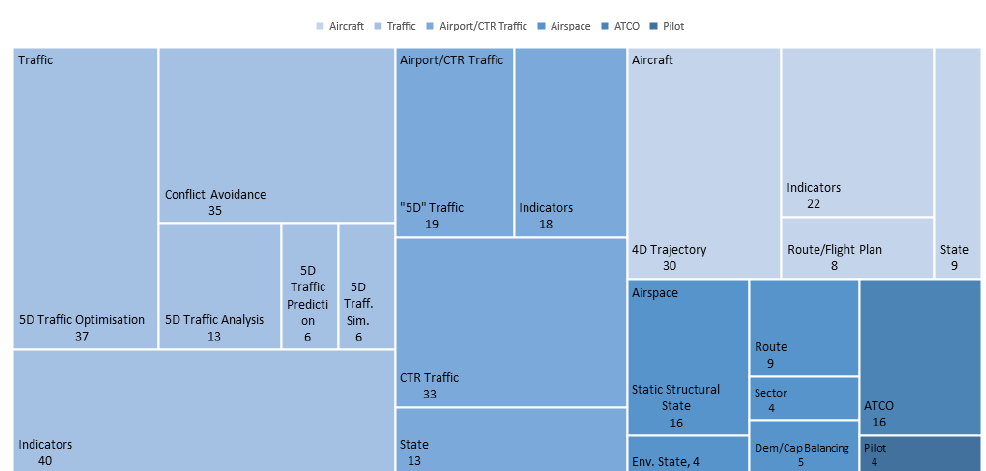
Figure 6. Tree map of the distribution of the articles in function of on the secondary extracted features from Table 4. Each rectangle represent a leaf of the table—the lowest level of description between object, complement, and sub-complement—, with the number of article focusing on this